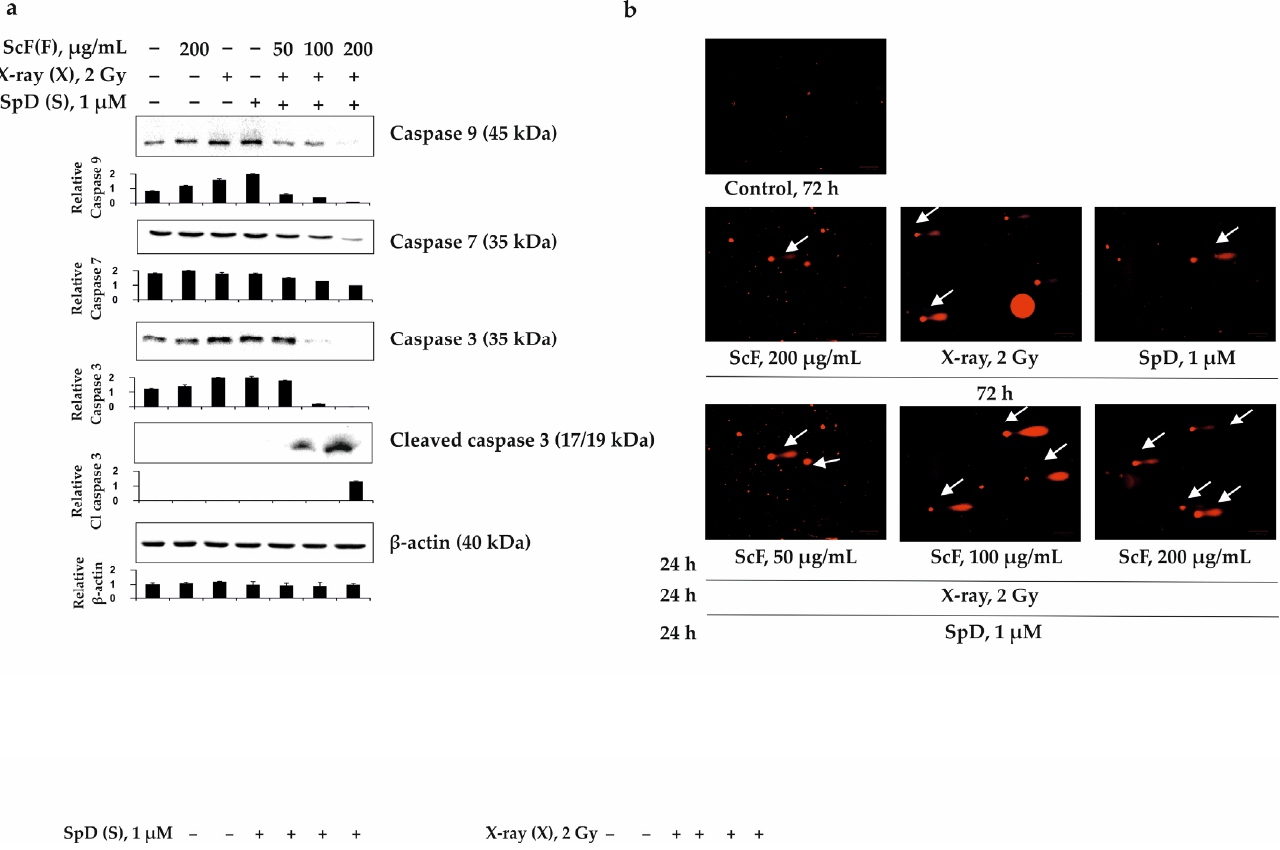
Figure 7. The combined radiomodifying effect of fucoidan from S. cichorioides (ScF) with X-ray and pacificusoside D from S. pacificus (SpD) on the induction of apoptosis and DNA degradation of 3D human melanoma SK-MEL-2. ( a ) Western blot analyses of caspase 9, 7, and 3 activation, and cleaved caspase 3 expression in spheroids treated by ScF in combination with X-ray and SpD for 72 h. β -actin was used as an internal control. Relative band density was measured using Image Lab™ Software 4.1. ( b ) DNA degradation of 3D SK-MEL-2 cells treated ScF in combination with X-ray and SpD for 72 h determined by the DNA comet method. Photographs ( n = 3, where n = number of photographs, scale 100 µm) of each spheroid were taken using the ZOE™ Fluorescent Cell Imager.